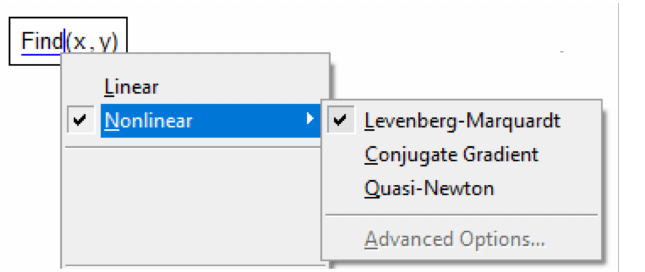
Figure 12. A snapshot of the instructions of the program in Mathcad 15 for selecting the numerical method.